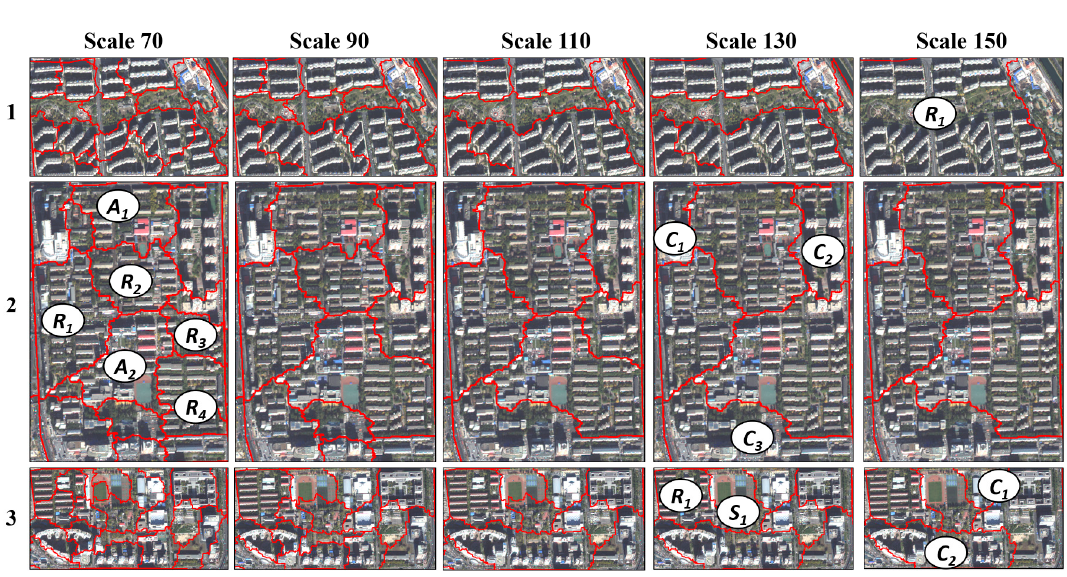
Figure 12. Multiscale segmentation results for the three regions in study area, with the scales of 70, 90, 110, 130, and 150. The red lines represent geoscene boundaries, and the labeled geoscenes are well segmented. R refers to residential districts, A campuses, C commercial zones, and S stadiums.